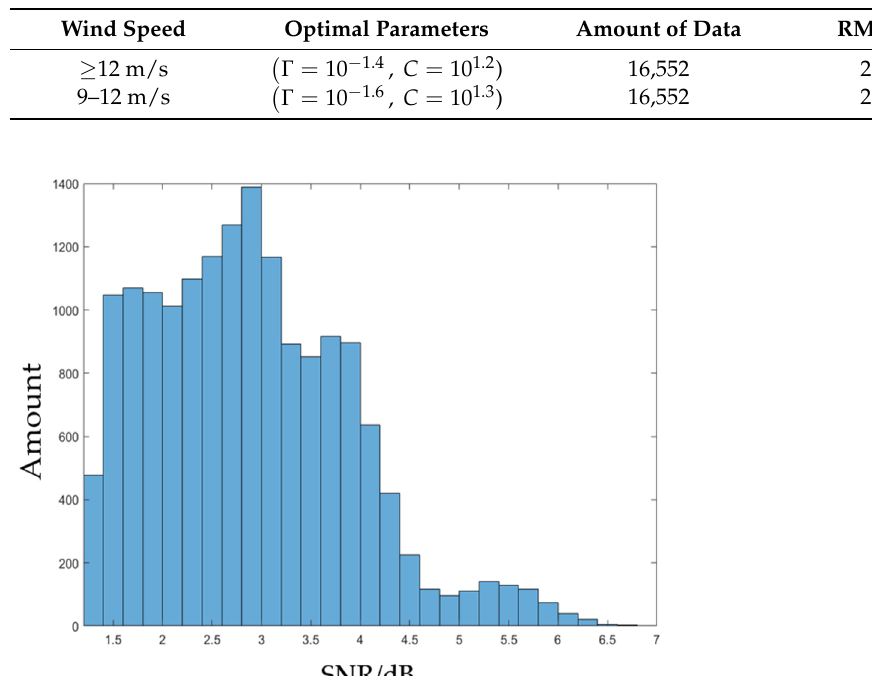
Figure 14. The number distribution of SNR with wind speeds between 9 and 12 m/s. Second, this paper analyzes the decrease in RMSE for wind speed greater than 15 m/s. There are a few data samples with wind speed greater than 15 m/s, and the data quality decreases. The high concentration of data samples in time and space should be the main reason for the decline of RMSE, but the impact of the reduction of data samples also needs to be studied. In this paper, 6498 data samples are randomly selected from the data set in the wind speed range of 12 to 15 m/s for the establishment of the SVM model. From Table 5, the RMSE at wind speeds of 12 to 15 m/s is higher than that at wind speeds greater than 15 m/s. It shows that under normal circumstances, the reduction of data and the reduction of data quality will lead to the increase of RMSE. However, the high wind speed data samples collected by the CYGNSS satellite are highly concentrated in time and space, which makes the RMSE lower. The SVM model established with this data set is not suitable for the retrieval of all wind directions. The wind direction infor- mation contained in the training data set is not complete.